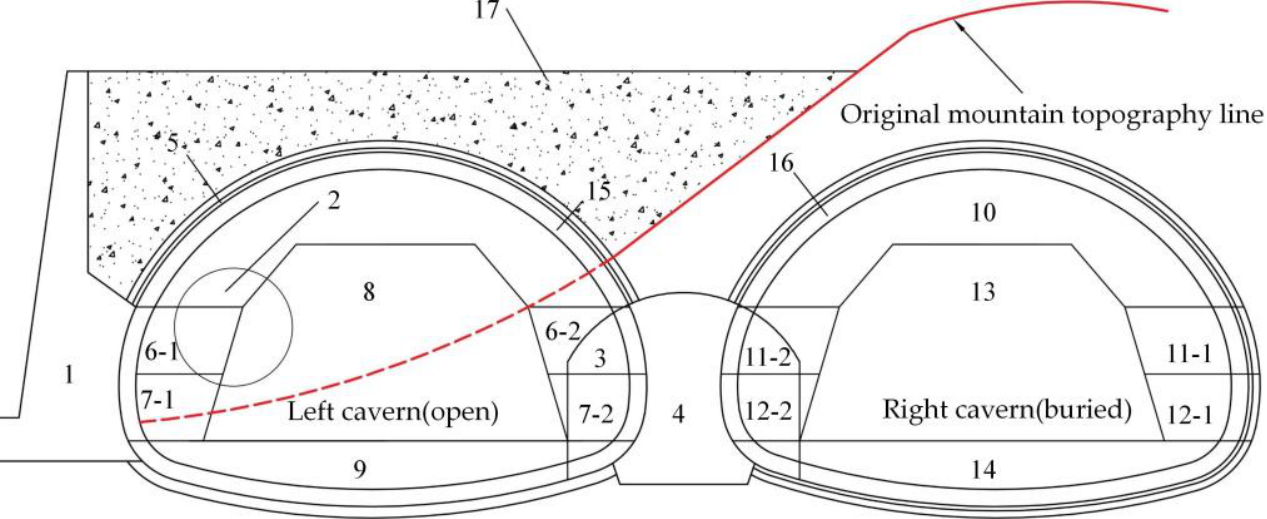
Figure 2. Schematic diagram of the construction process of the open-buried double-arch and bias tunnel. Table 2. The main construction and its construction sequence.